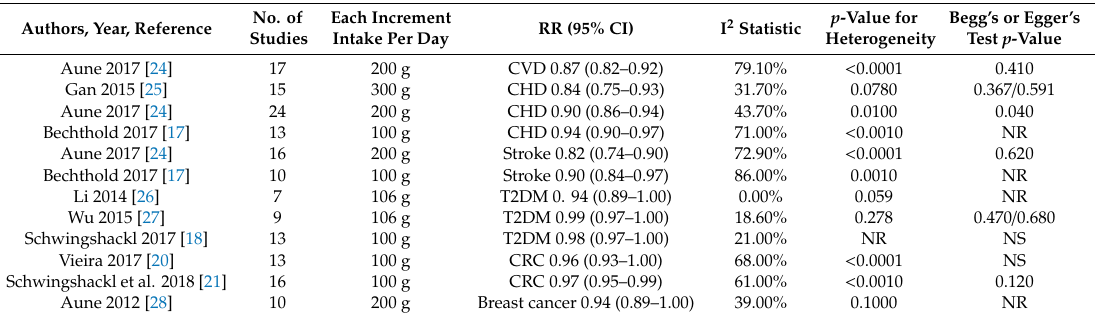
Table 3. Summary of linear dose-response meta-analyses of prospective studies on fruit intake and CVD, CHD, stroke, T2DM, CRC, breast